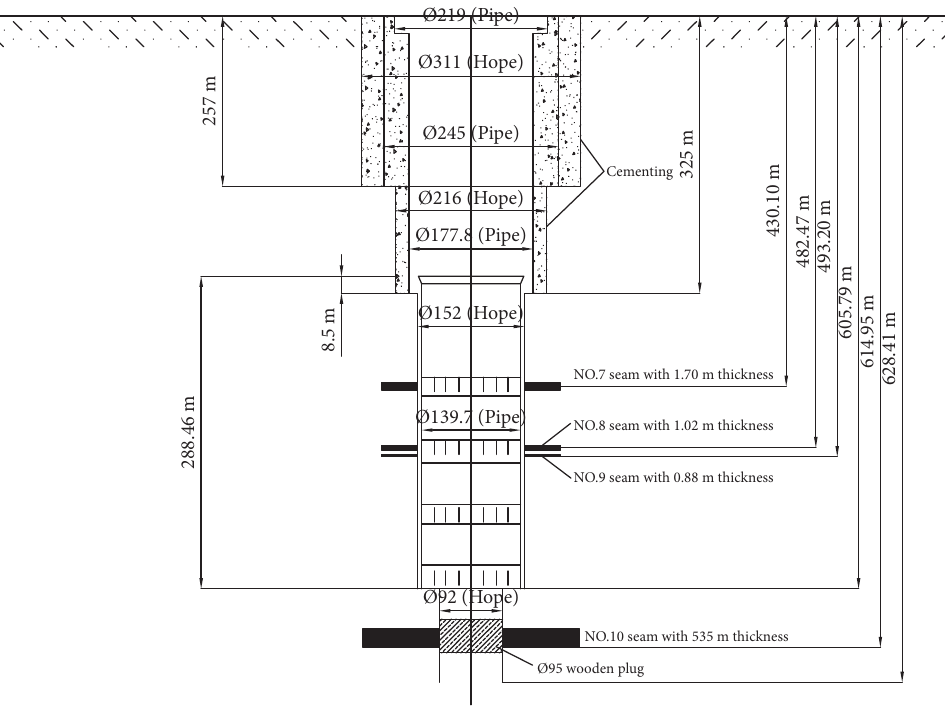
Figure 9: Schematic diagram of surface well’s structure in No. 2 1024 panel.